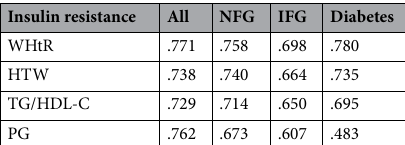
Insulin resistance